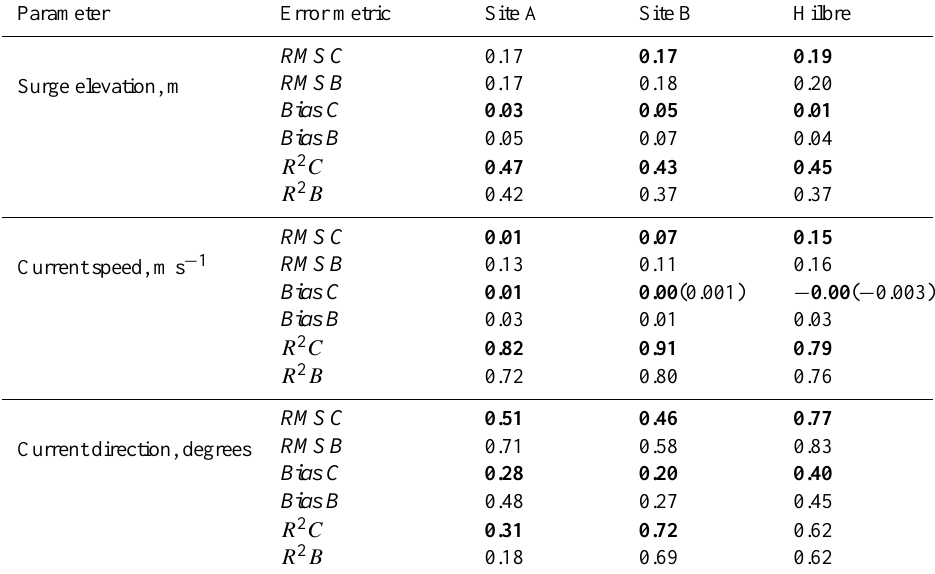
Table 2. The validation metrics ( RMS error, mean bias and R 2 ) showing the overall accuracy of the Charnock relation ( C) and the COARE bulk wind stress formula ( B) at the three study sites. For zero values an extra degree of precision has been included in the bracketed value. The value representative of higher accuracy is shown in bold